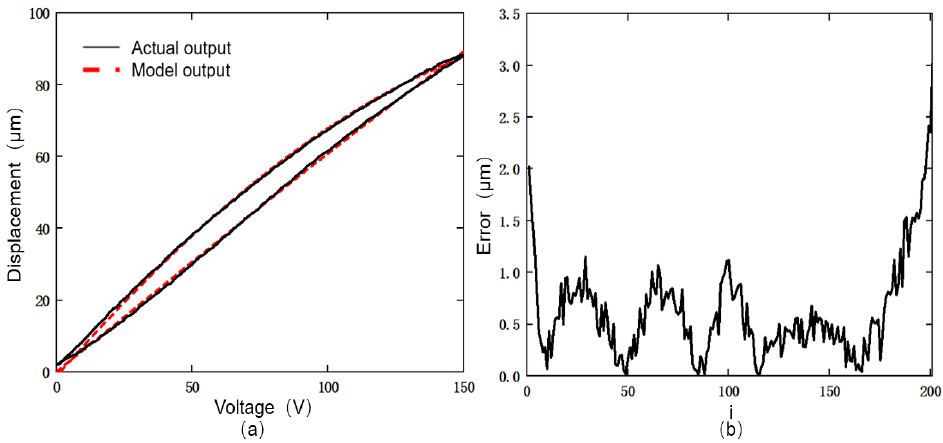
Figure 6. Fitting error plot between model data and experimental data: ( a ) fit plot; ( b ) error plot.